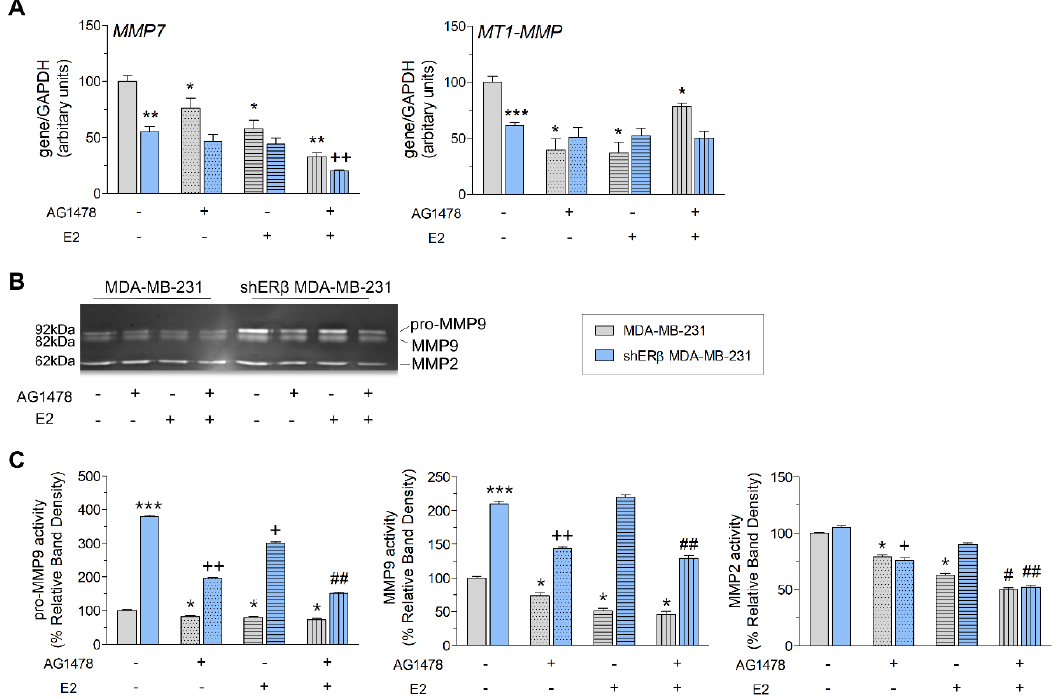
Figure 1. EGFR inhibition affects the expression and activity levels of proteases in MDA-MB-231 and shERβ MDA-MB-231 breast cancer cells. ( A ) Quantitative RT-PCR analysis of MMP7 and MT1-MMP mRNA levels after 24 h without and with treatments (AG1478, E2 and mix). ( B,C ) MMP2/MMP9 gelatinolytic activities (as assayed by gelatin zymography) in MDA-MB-231 and shERβ MDA-MB-231 cells, before and after treatments (AG1478, E2, mix and 24 h). Each bar represents mean ± SD values from triplicate samples. Statistically significant differences are indicated accordingly: * p < 0.05, ** p < 0.01 and *** p < 0.01 compared to MDA-MB-231 control cells; + p < 0.05 and ++ p < 0.01 compared to shER β MDA-MB-231 control cells; and # p < 0.05 and ## p < 0.01 compared to E2-treated